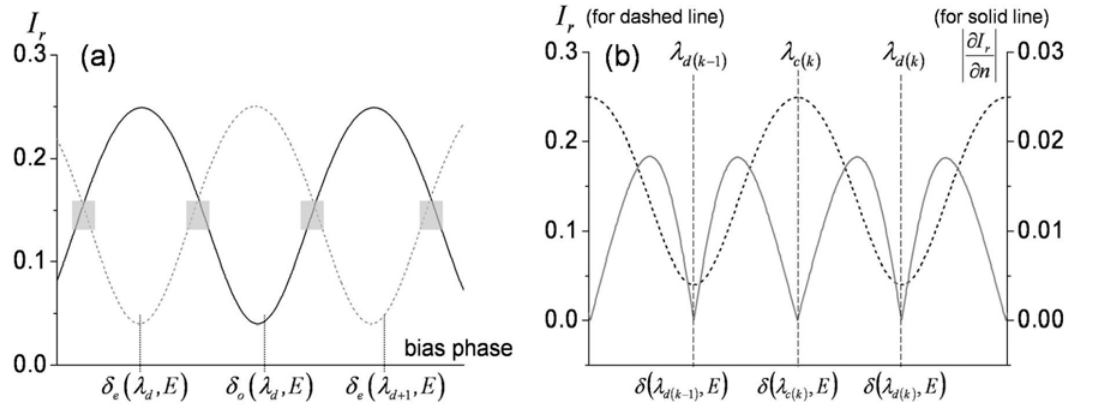
Figure 4. (a) Simulated reflectance fringes for type II probe (in Figure 3) versus bias phase retardation in terms of wavelength ( λ : 1550~1560 nm; h = 0.1 mm; solid line: n dashed line: n case; r : fiber-LiTaO ; r : LiTaO - air ; C = 1) [17]; (b) Total reflectance and e 1 3 2 3 reflectance change for 0.01% modulation of n (for dashed reflectance in Figure 4(a), with e two interference fringes shown).